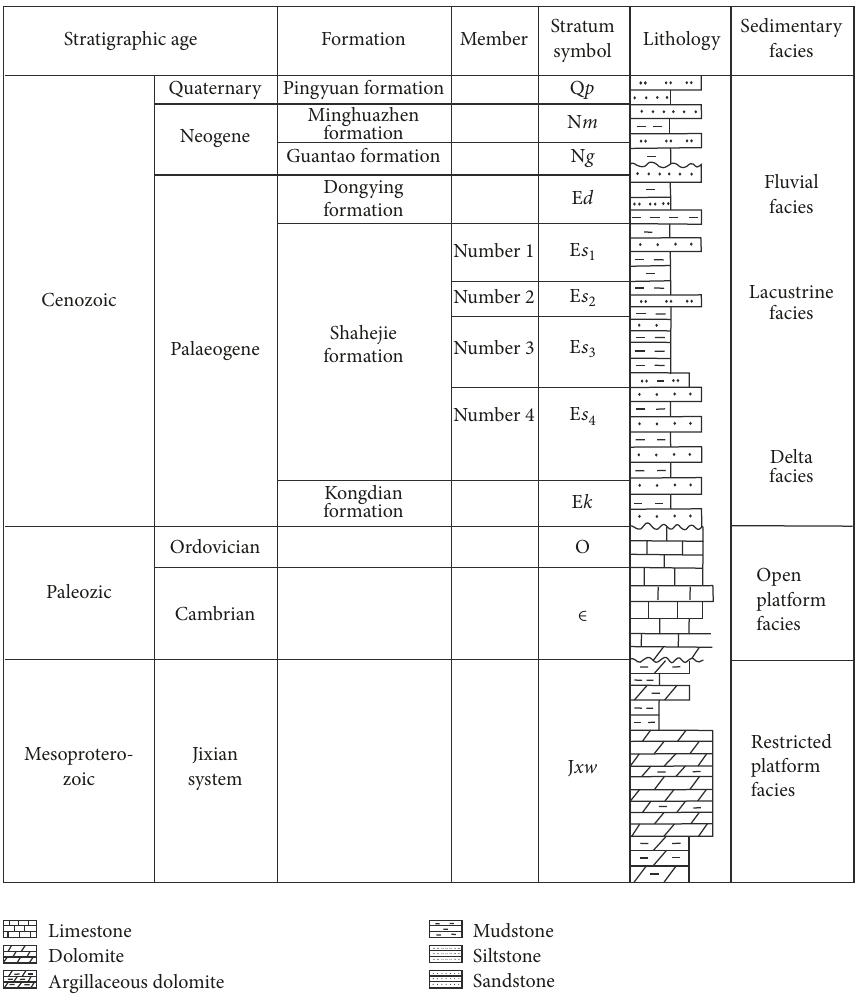
Figure 2: Stratigraphic histogram of the Jizhong Depression.